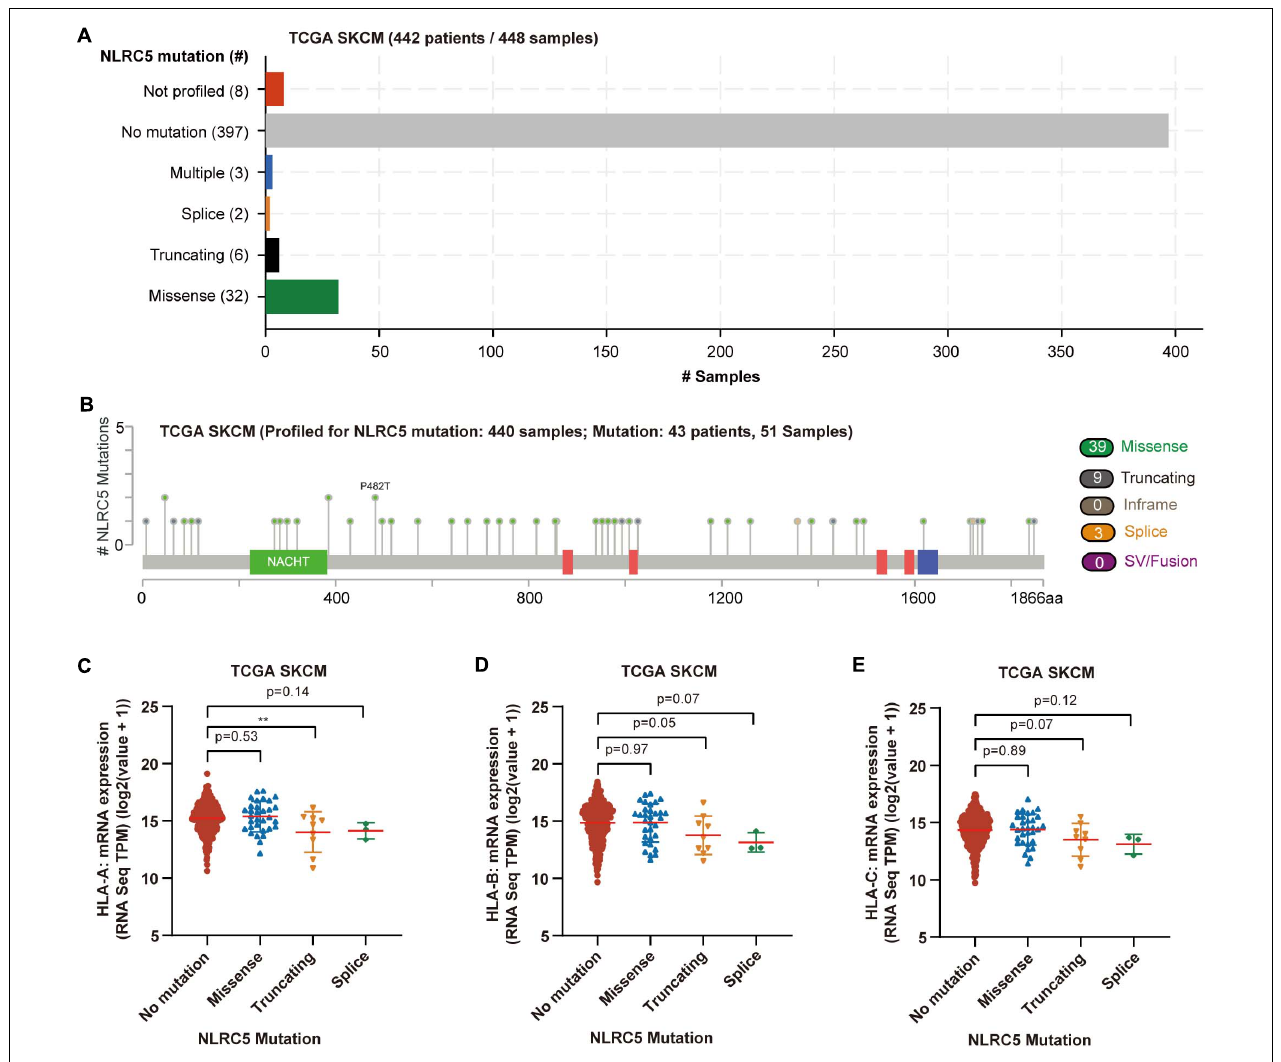
FIGURE 5 | Mutation of NLRC5 in TCGA SKCM. (A) Samples with different mutation status of NLRC5 gene. (B) Distribution of mutation sites in NLRC5 gene. (C–E) Effect of different NLRC5 mutations on HLA-A (C) , HLA-B (D) , and HLA-C (E) expression, respectively. Statistical analysis between every two groups performed by a two-tailed Student’s t -test. P values were shown as indicated. ** p <